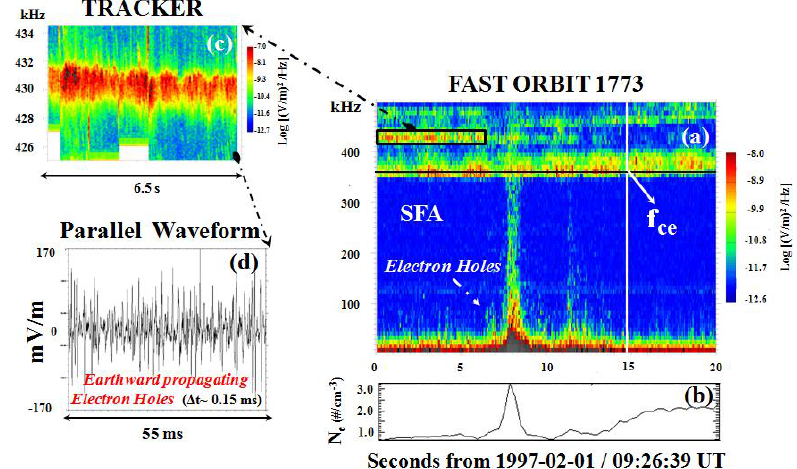
Figure 7. Crossing of an AKR source region during FAST orbit 1773. The presence of a localized DL can be derived from the SFA data (a) around 09:26:46UT when sporadic broadband electrostatic emissions are detected indicating the presence of EHs. These nonlinear structures are displayed from 09:26:45.769UT for a 55ms period in (d) . The fine AKR structures recorded by the tracker during 6.5s from 09:26:39UT are illustrated in (c) ; they cover a frequency range of about 2kHz (430–432kHz). Again, this event took place on the flanks of an enhanced density structure as illustrated in (b)